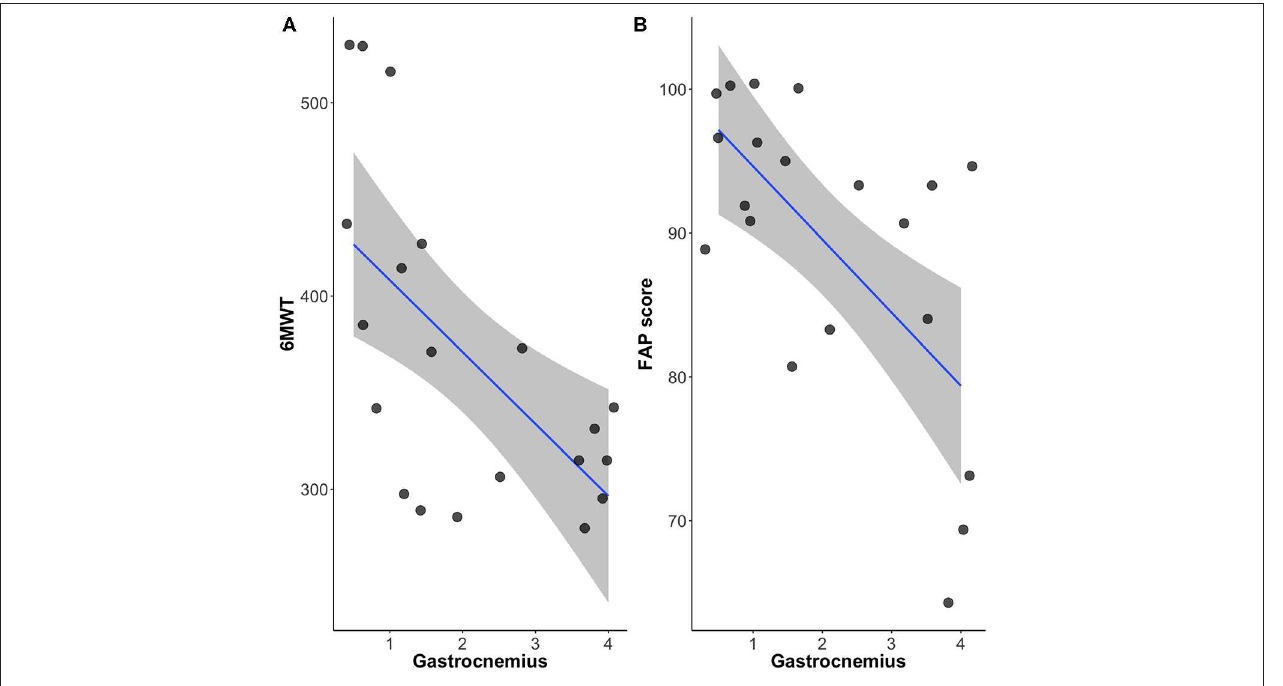
FIGURE 3 | The relationship among gastrocnemius, (A) 6 minute walk test and (B) FAP